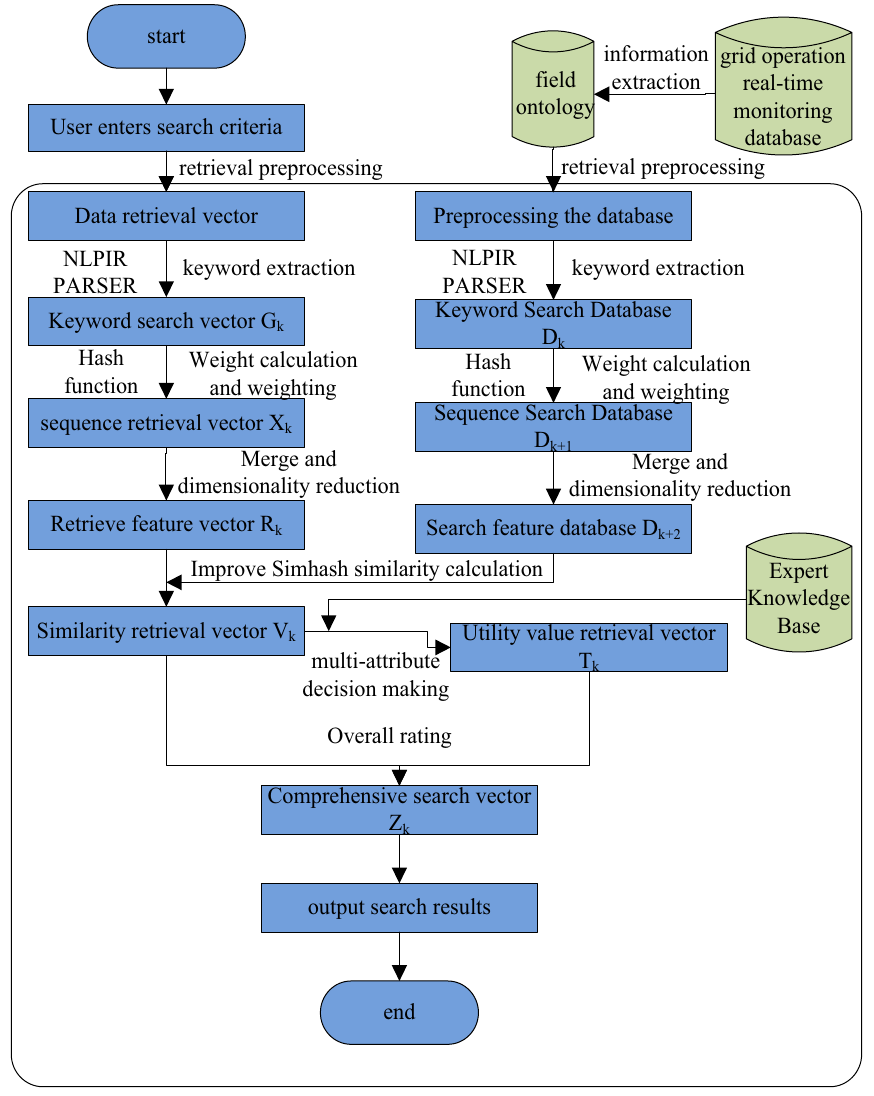
Figure 1. Principle block diagram of MR-ST